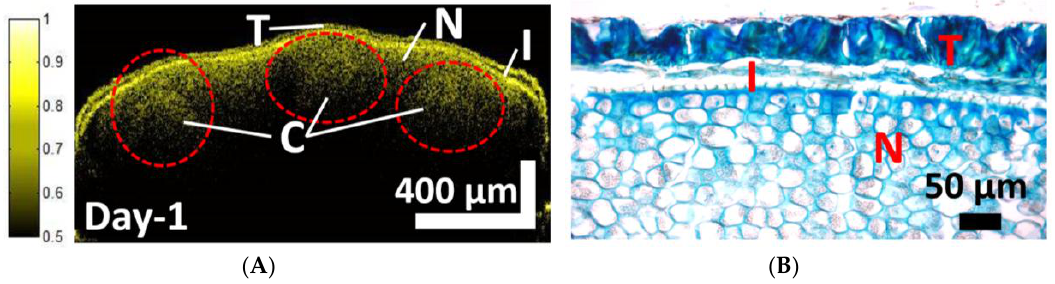
Figure 2. A 2D SS-OCT image and a histological image. ( A ) A 2D-SSOCT image of a seed primed with sterile distilled water for one day. ( B ) An enlarged histology image of the same seed that was used in ( A ). C: Cotyledon; I: Inner seed coat; N: Non-micropylar endosperm; T: Testa. Dashed red circle shows the enclosed cotyledon regions.